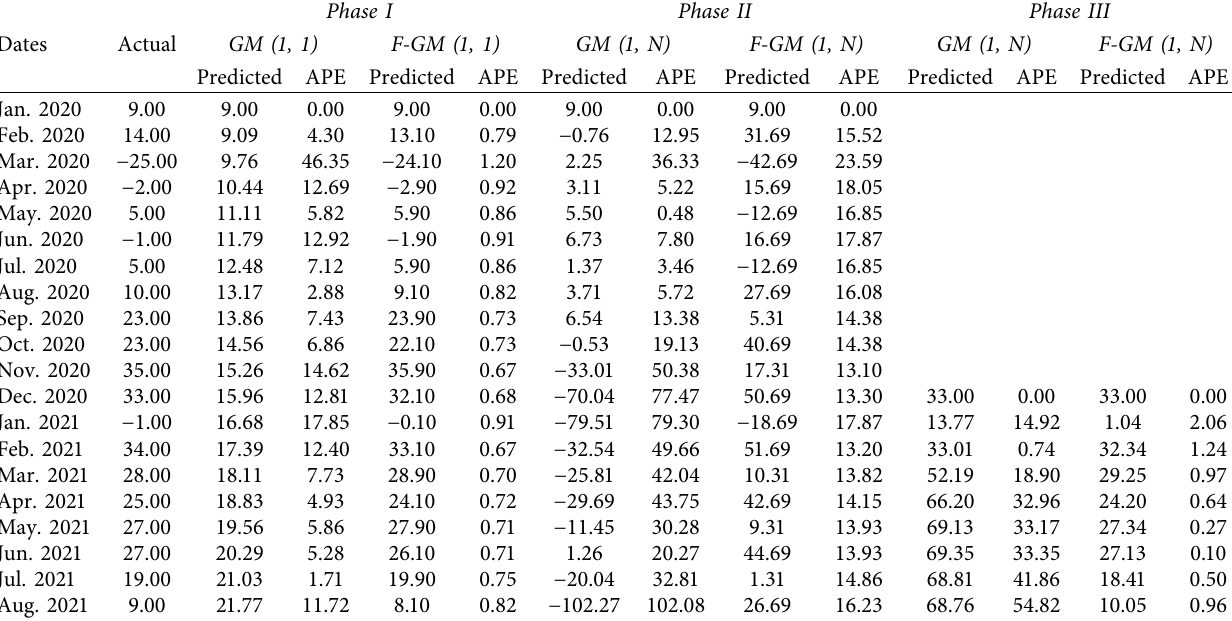
Table 14: Prediction results of travel sentiment in the